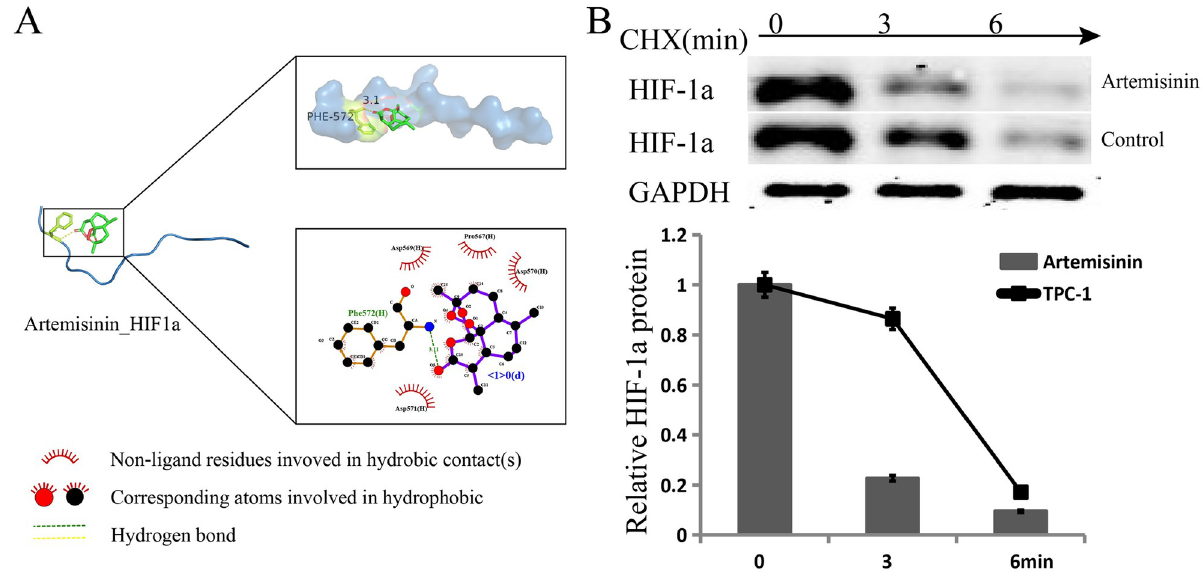
Fig 4. Artemisinin targets and degrades HIF-1a. (A) The binding site of artemisinin and HIF-1a. (B) The half-life of HIF-1a protein was assessed in TC cells. Cells were treated with artemisinin.